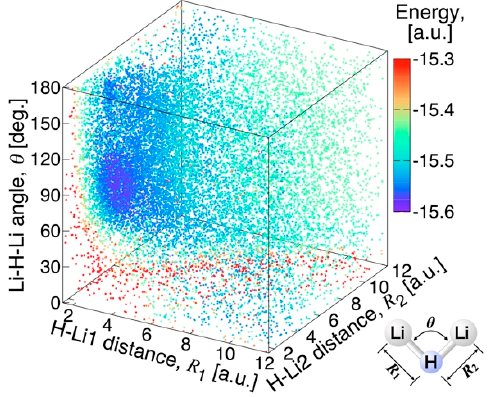
Figure 1. Distribution of the ab initio points for the ground state of Li 2 H.